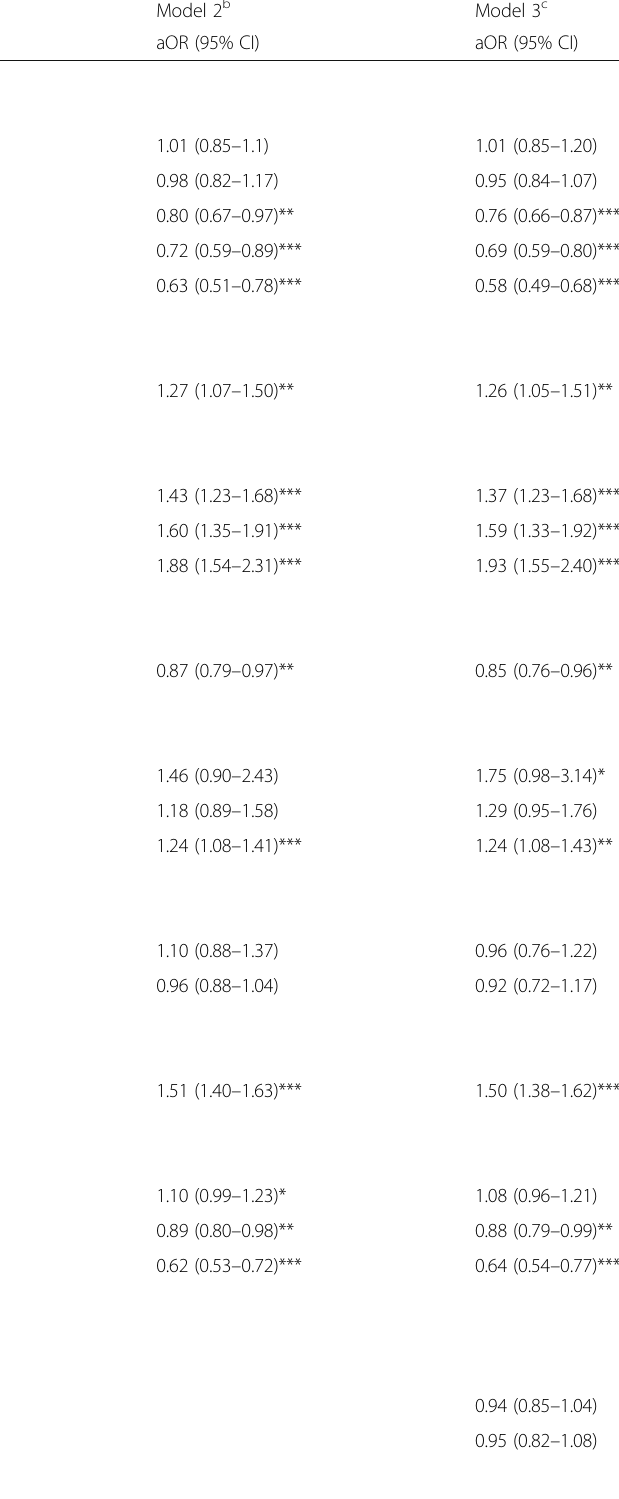
Table 2 Multivariate associations between sociodemographic characteristics, socioeconomic status, media exposure and IPV among women of reproductive age (15 – 49 years), Zimbabwe, pooled data from 2005 to